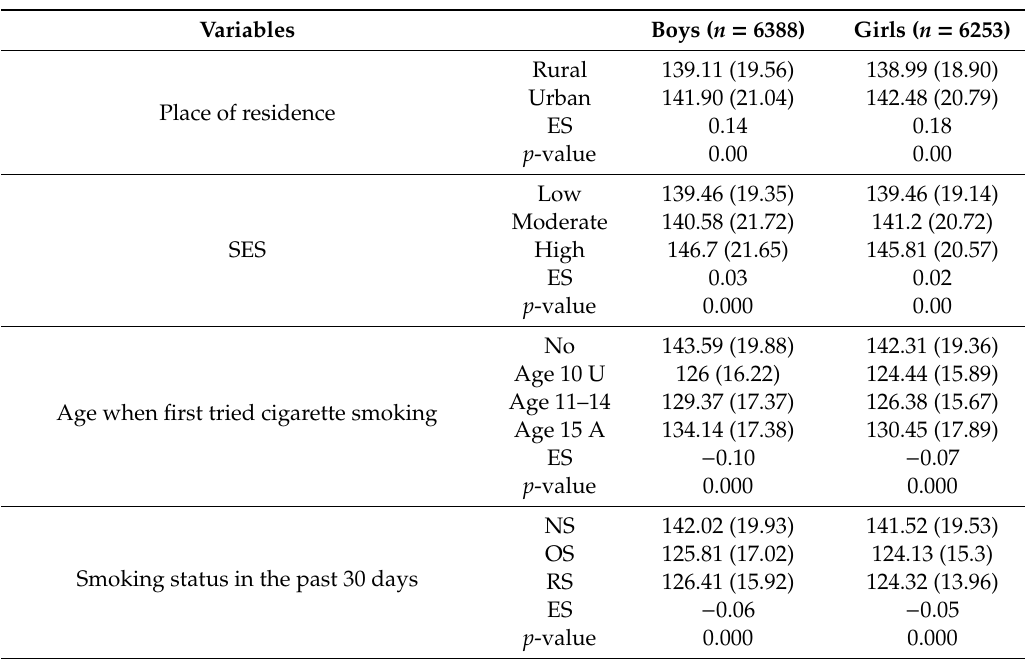
Table 2. Mean (SD) of total quality of life (QOL) component according to the level of demographic characteristics, screen time and physical activity among adolescents. Data are means